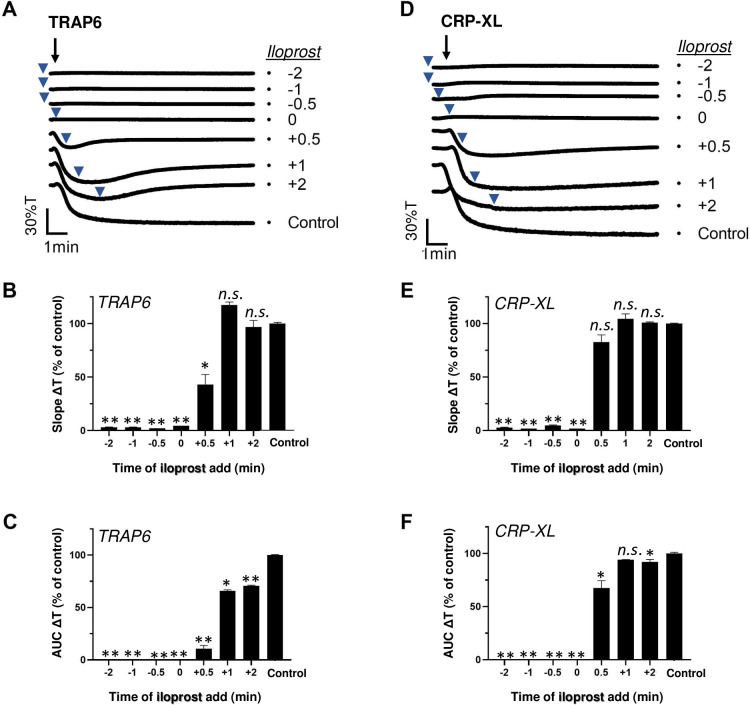
Post-hoc inhibitory effect of iloprost on TRAP6- and CRP-XL-induced platelet aggregation.Platelets in suspension were stimulated with 10 μM TRAP6 (A-C) or 5 μg/mL CRP-XL (D-F), and aggregation was recorded by light transmission aggregometry. Iloprost (10 nM) was added before (-2, -1 or -0.5 min), simultaneously with (0 min) or after (+0.5, +1, +2 min) the indicated agonist. Representative traces are shown); arrows indicate addition of agonist, arrowheads addition of iloprost (A, D). Graphs of aggregation slope as %T/min (B, E) and aggregation-area-under-the-curve (AUC, 10 min) (C, F), as fractions of control without iloprost. For maximal %T values, see S1 Data. Means ± SEM (n = 3). *P<0.05, **P<0.001 vs. control traces, paired Student t-test.